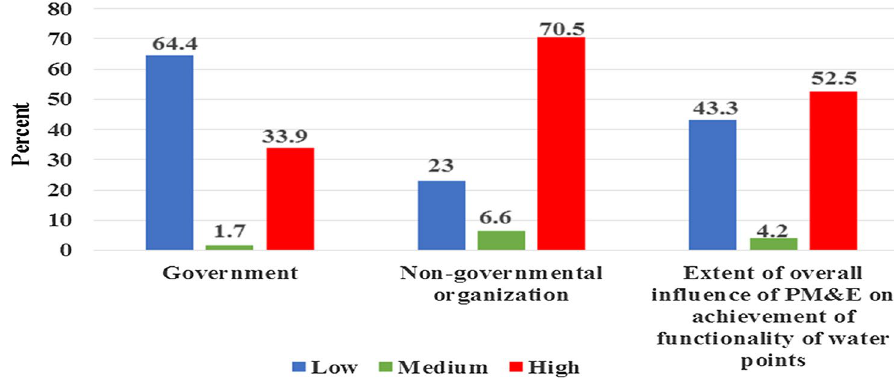
Fig. 4 Effectiveness of PM&E in ensuring functionality of water points